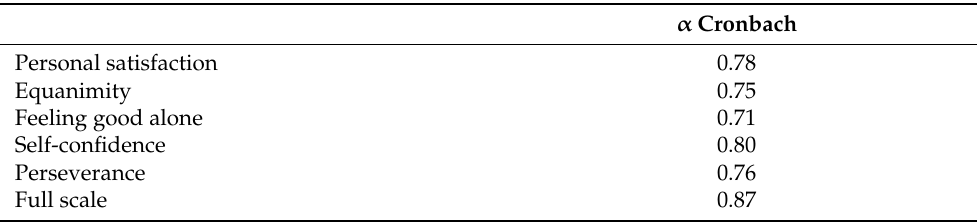
Table 3. Reliability of the Resilience